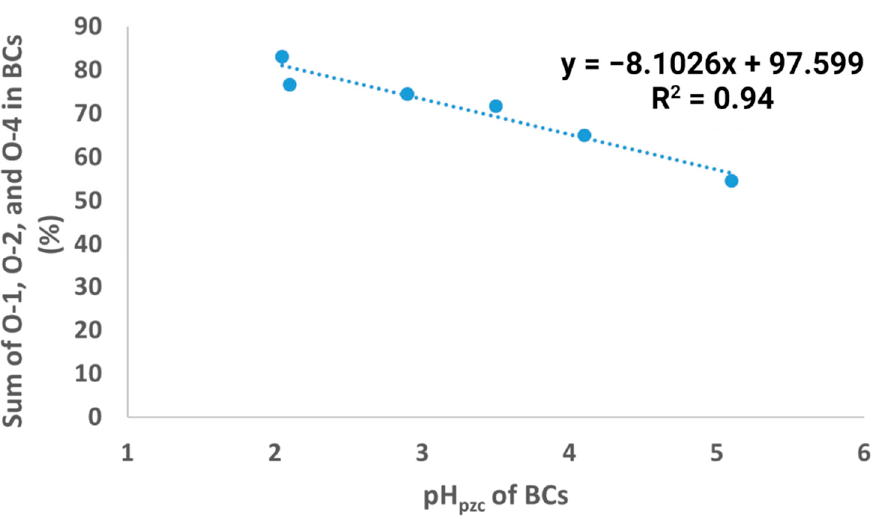
Figure 6. Correlation between the summation of O-1%, O-2%, O-4%, and pH pzc of biochar samples.